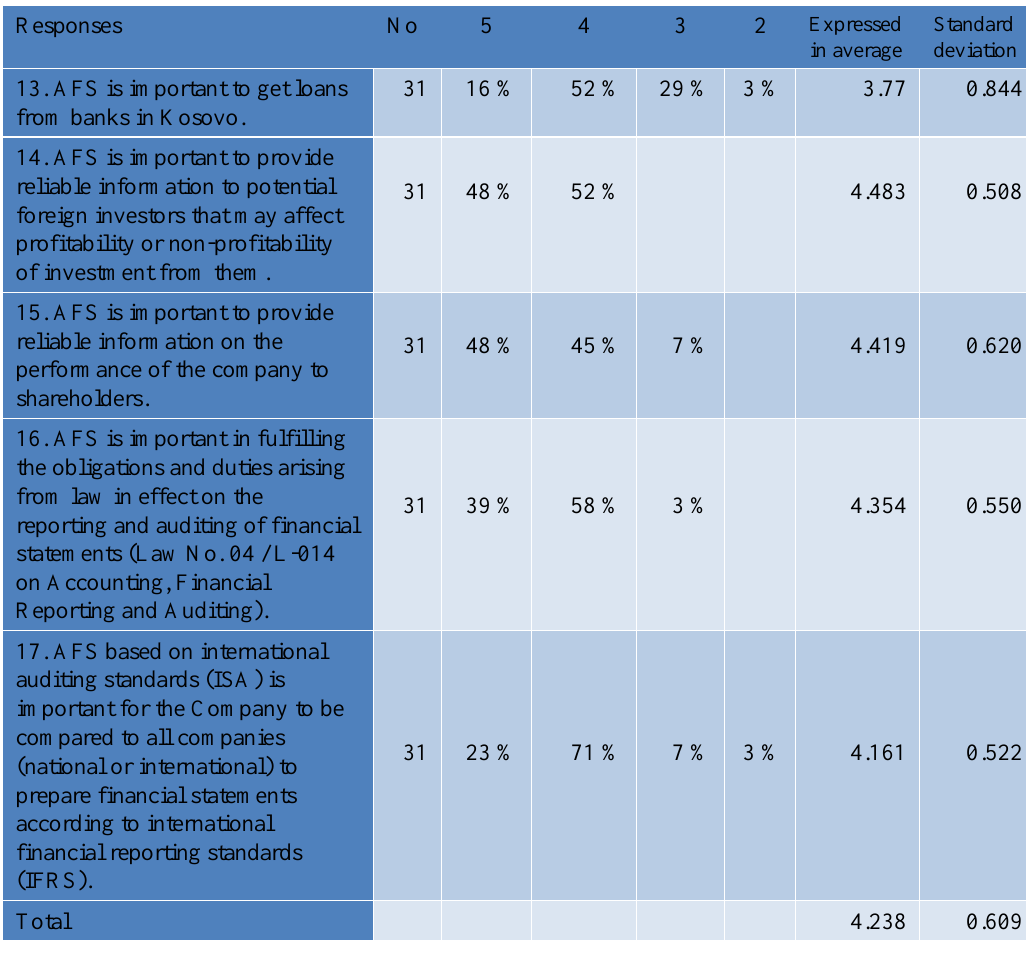
Table. 4. Factors determining importance of the audited financial statements [Table and calculations made by